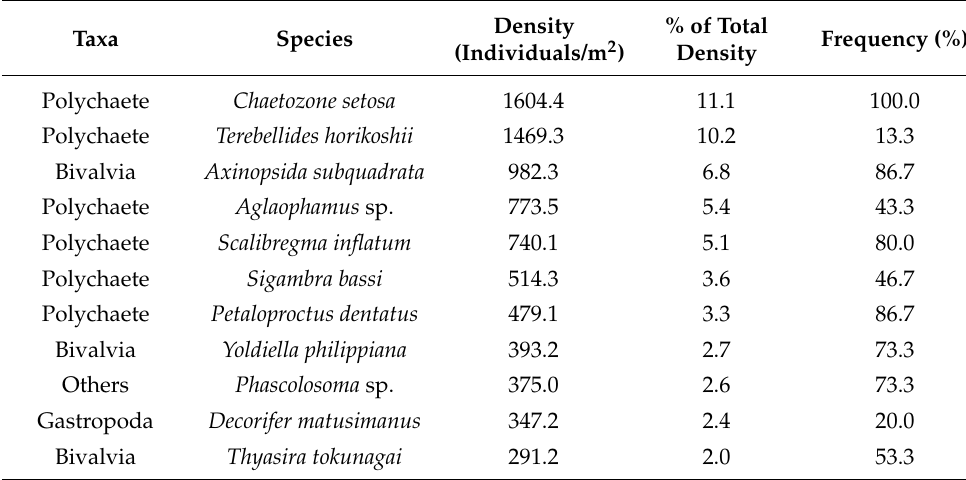
Table 3. Dominant species based on macrobenthos density.